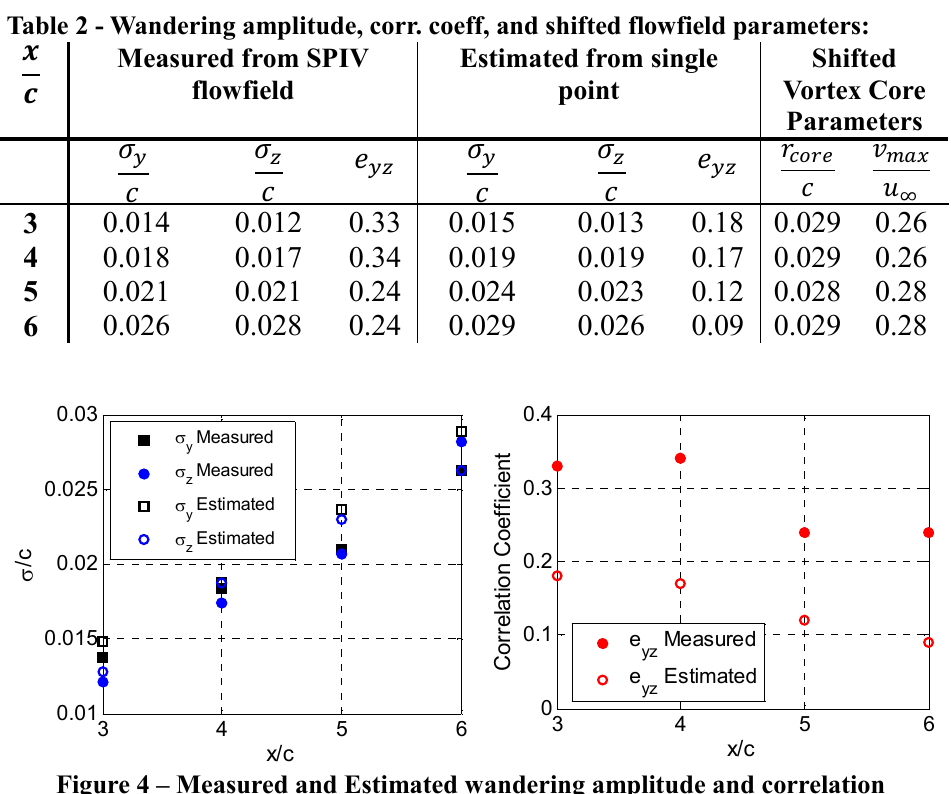
Table 2 - Wandering amplitude, corr. coeff, and shifted flowfield parameters: